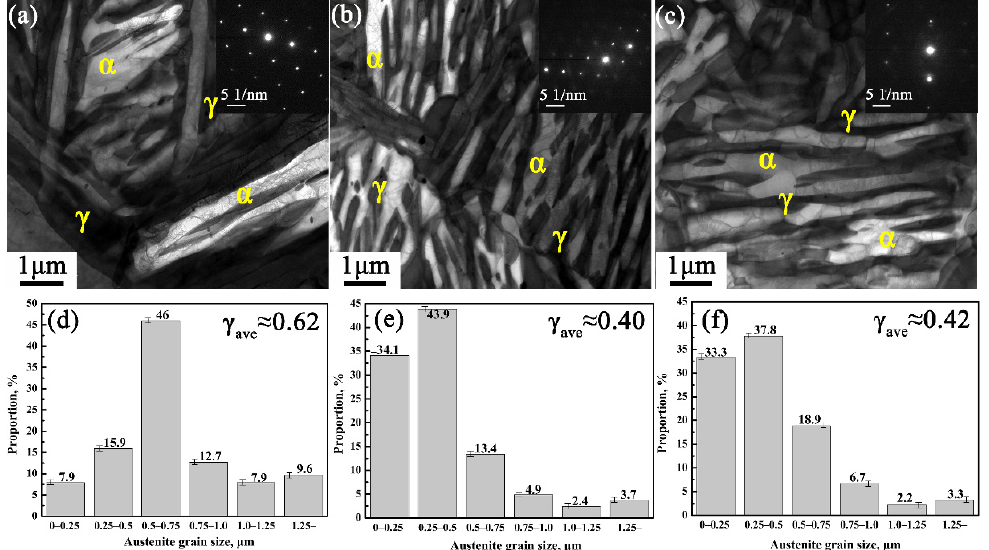
Figure 2. TEM microstructure and grain size of experimental steel with different numbers of quenching cycles: ( a , d ) CQ1-ART, ( b , e ) CQ2-ART, and ( c , f ) CQ3-ART.